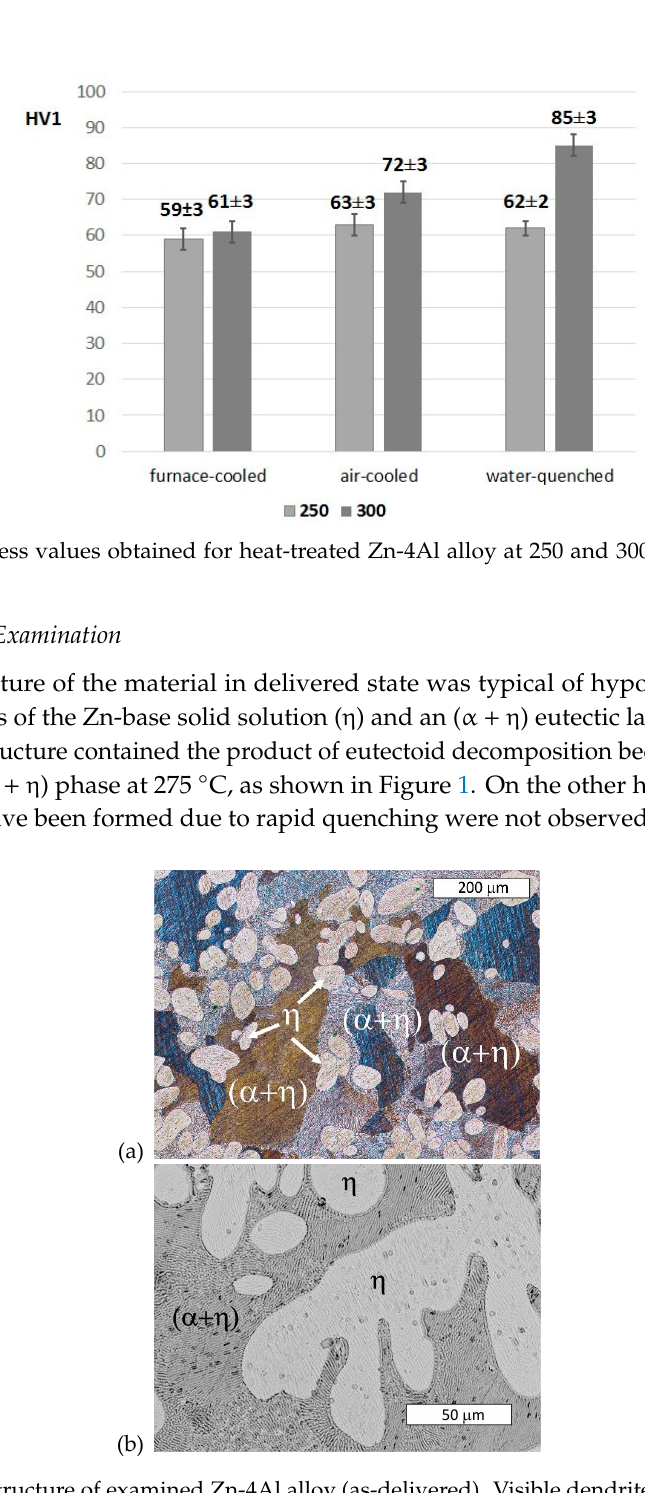
Figure 3. Microstructure of examined Zn-4Al alloy (as-delivered). Visible dendrites of η phase and a eutectic lamellar morphology ( α + η ). Etched with 10% NaCl solution. ( a ) Light Microscopy, ( b ) SEM.